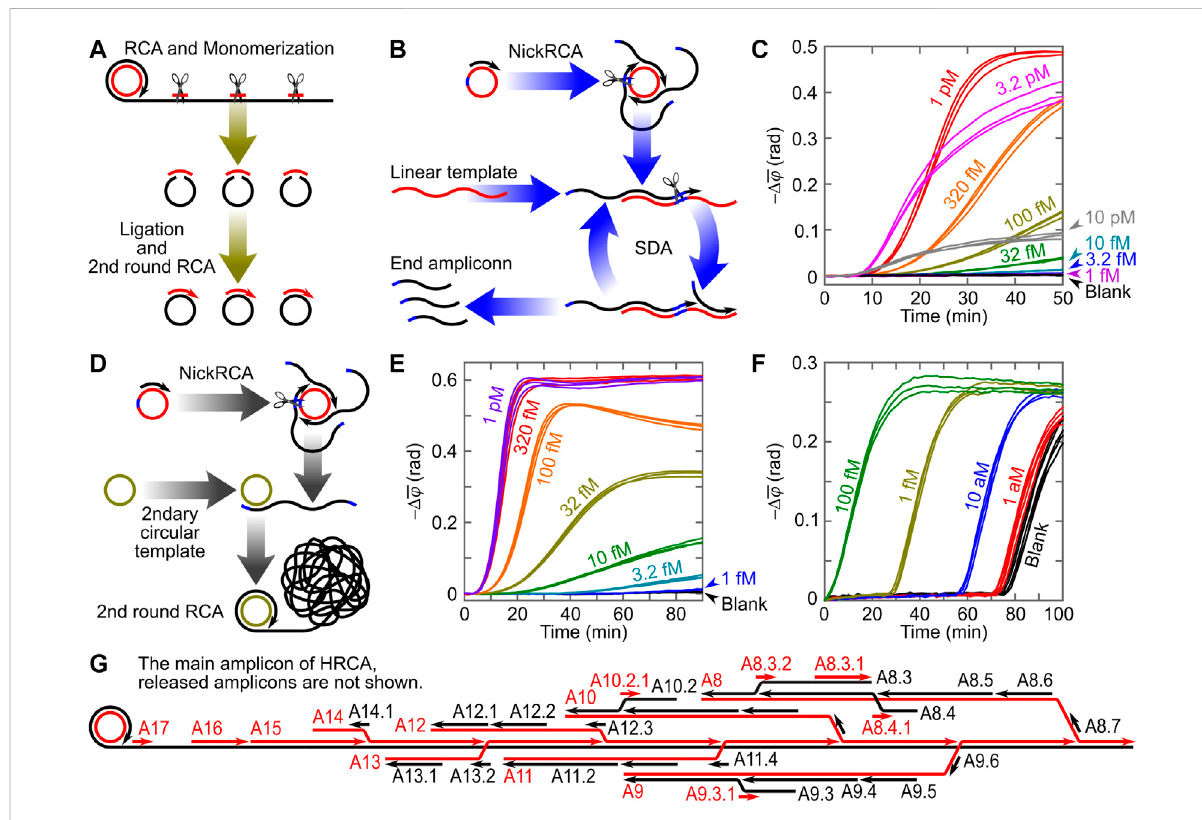
FIGURE 2 (A) Schematic illustration of conventional C2CA. (B,C) Schematic illustration and time-resolved optomagnetic signals (phase lag increases) of NECA-based VAMNDA. (D,E) Schematic illustration and time-resolved optomagnetic signals of HC2CA-based VAMNDA. (F) Time-resolved optomagnetic signals of PG-RCA-based VAMNDA. Panels (C,E,F) are adapted with permission from Tian et al. (2020a, 2020b, 2020c), Copyright 2020, Elsevier and Oxford University Press. (G) Illustration of HRCA processes on the RCA coil (amplicons that have already been released from the RCA coil are not shown). A8 means the eighth amplicon produced on the RCA coil (A1-A7 have been released), and A8.3 means the third amplicon produced on A8 (A8.1 and A8.2 have been